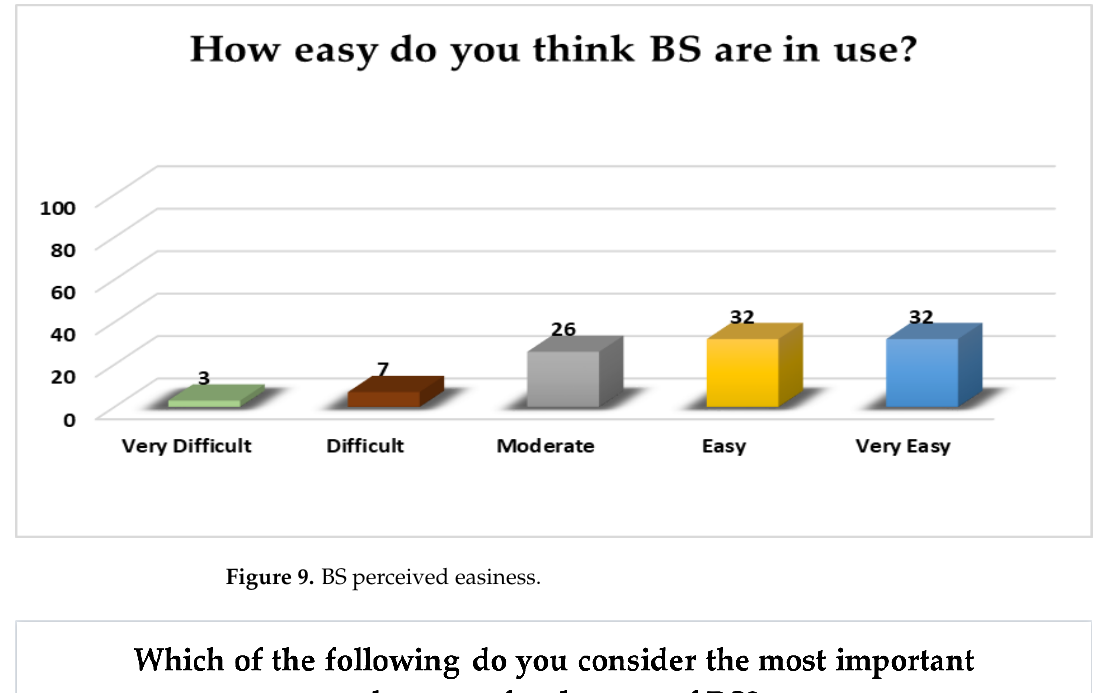
Figure 9. BS perceived easiness .